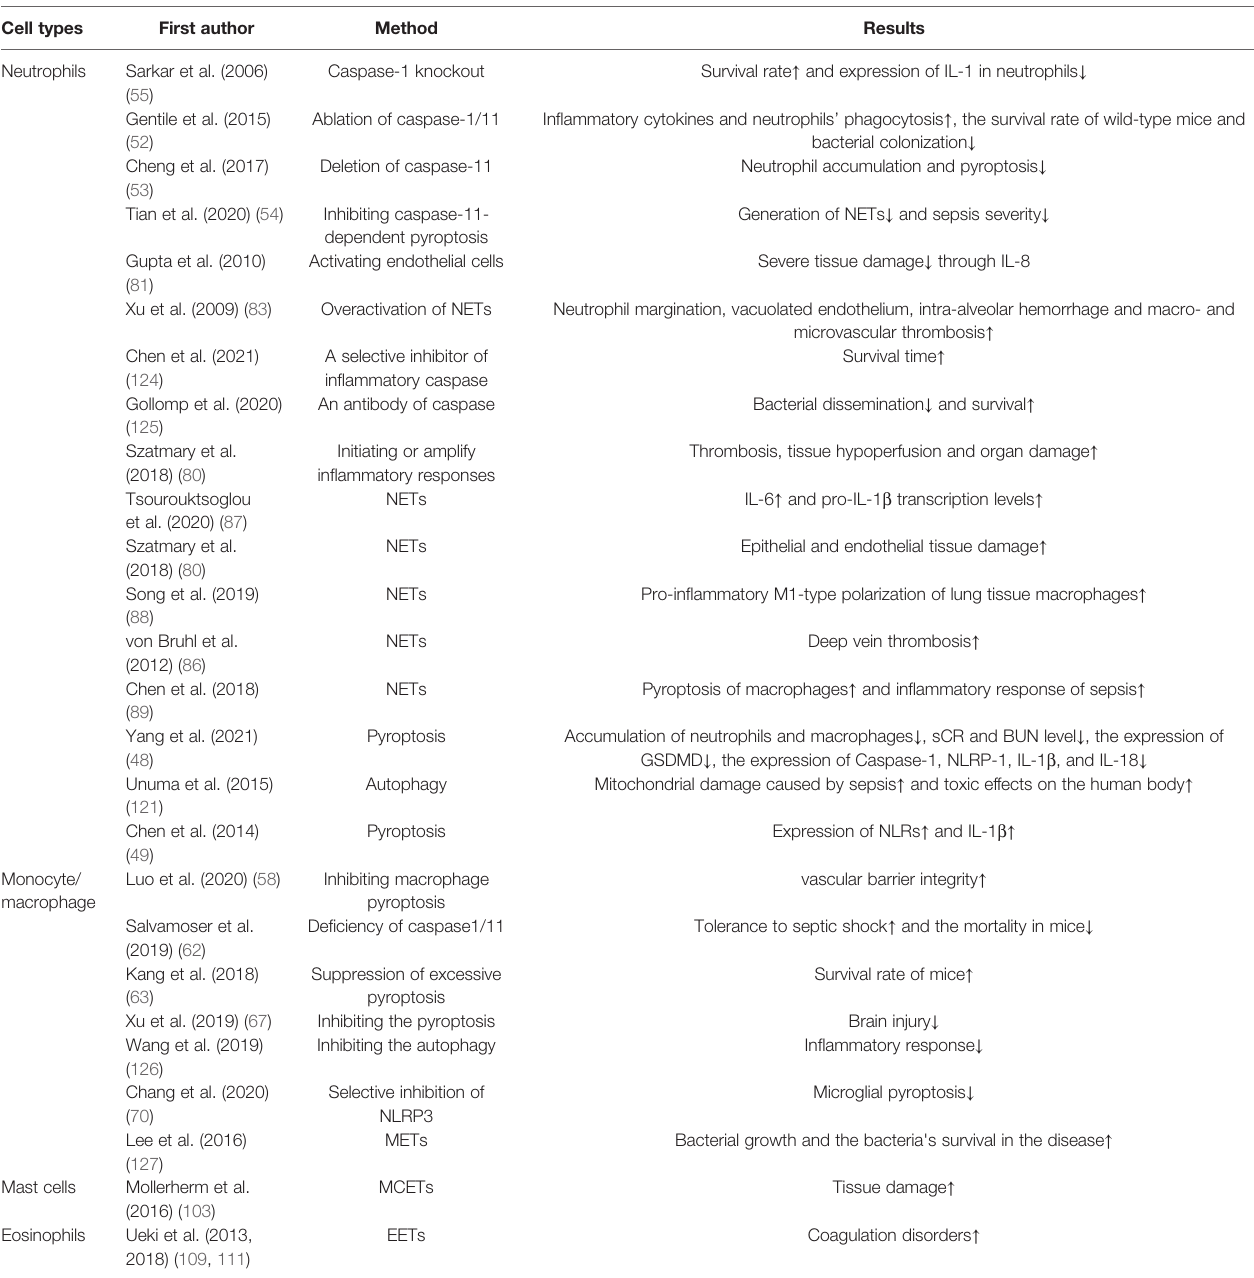
TABLE 3 | The cons of various self-sacri fi ce of immune